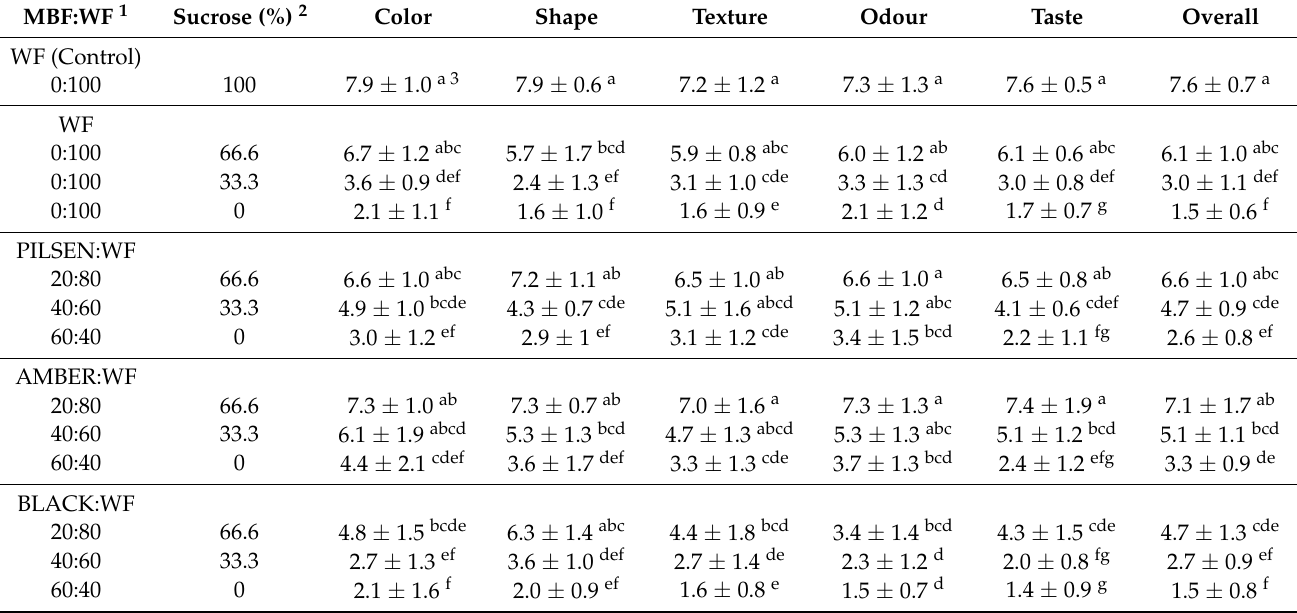
Table 2. Sensory scores of cookies made from malted barley and wheat composite flours with reduced sucrose